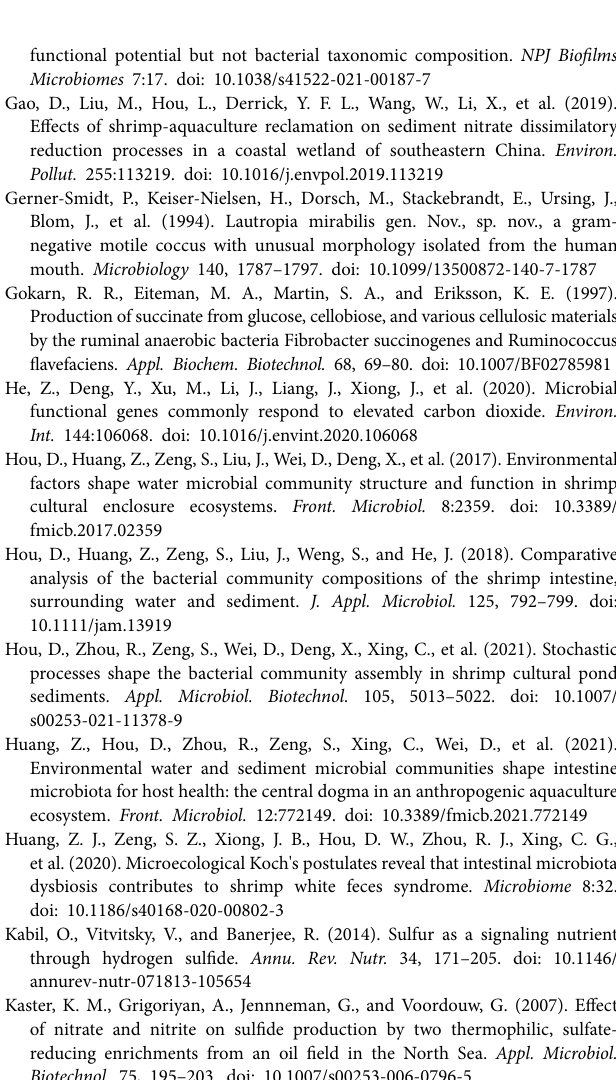
Supplementary Figure S4 | Temporal distance-decay analysis of functional genes and the bacterial community during shrimp